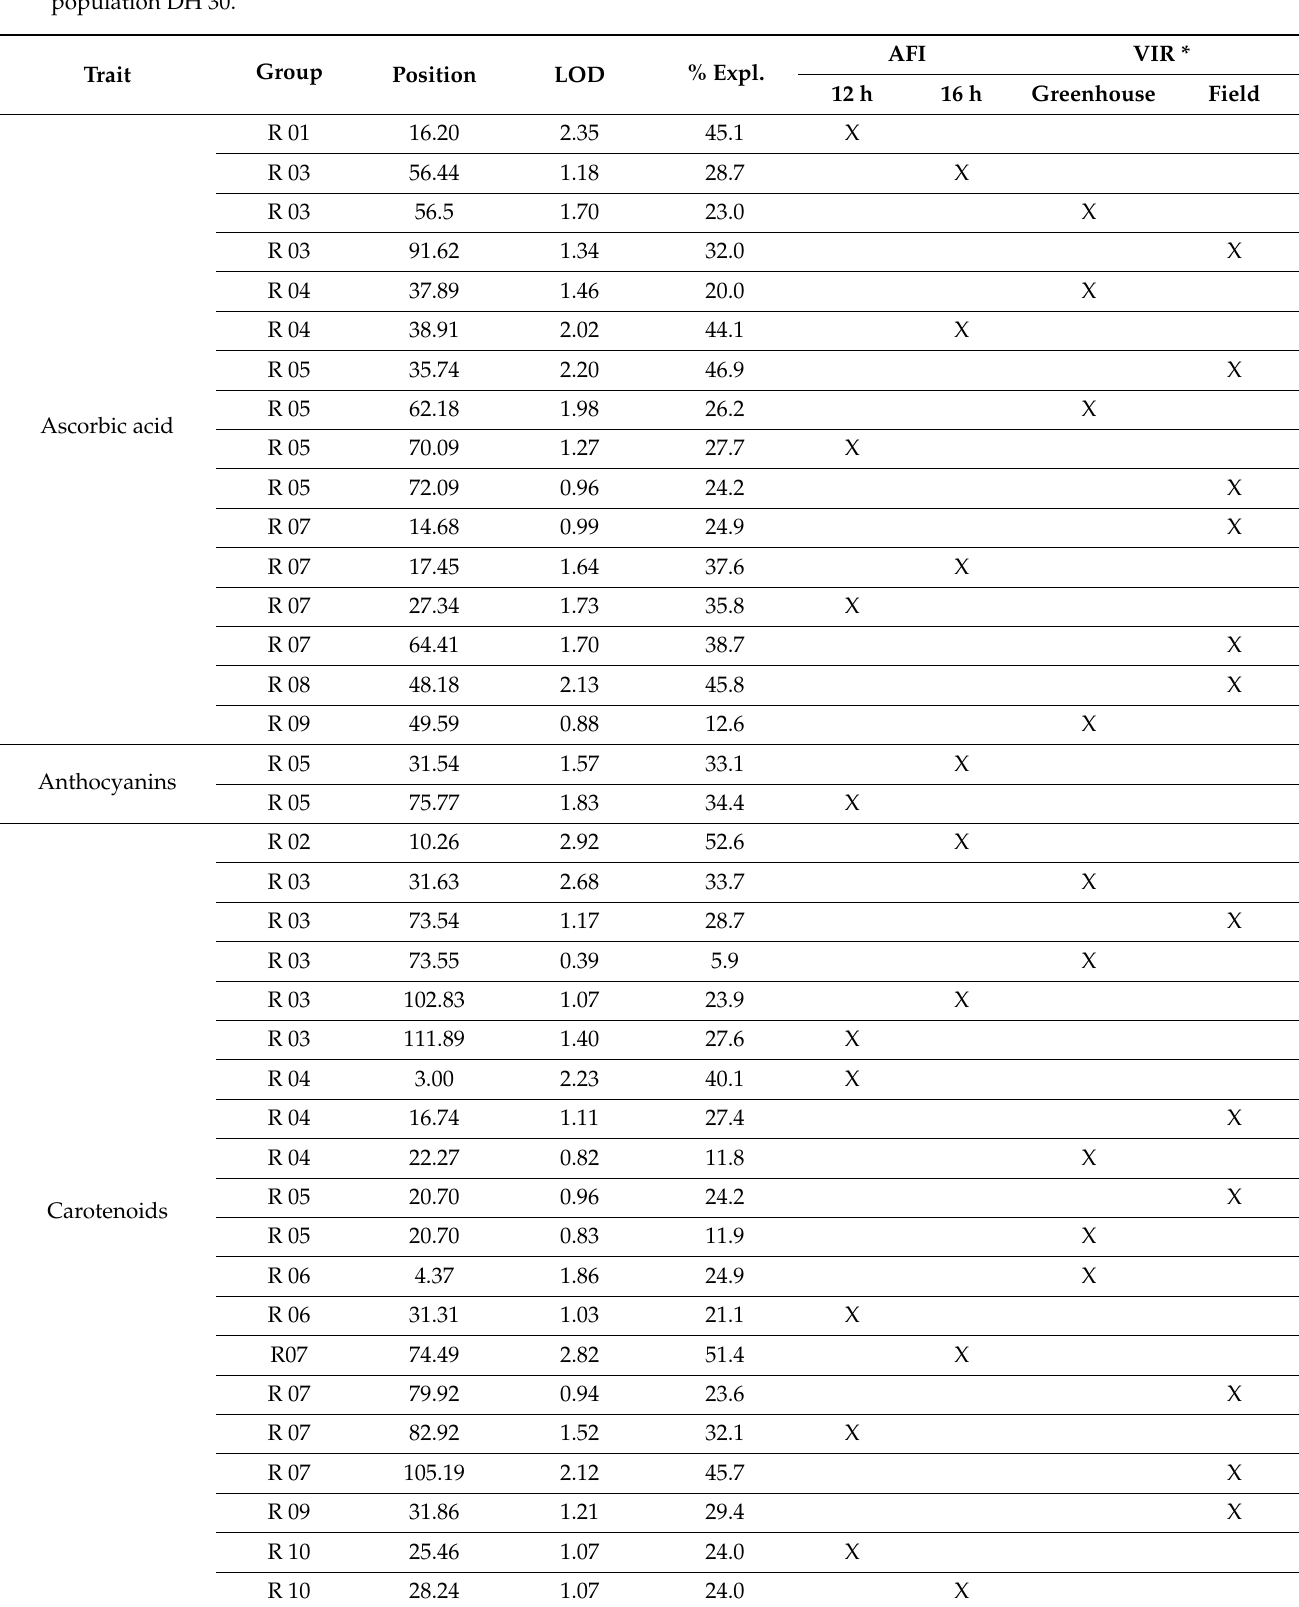
Table 3. QTL mapping of loci that determine the content of biologically active substances and nutrients in the mapping population DH 30.